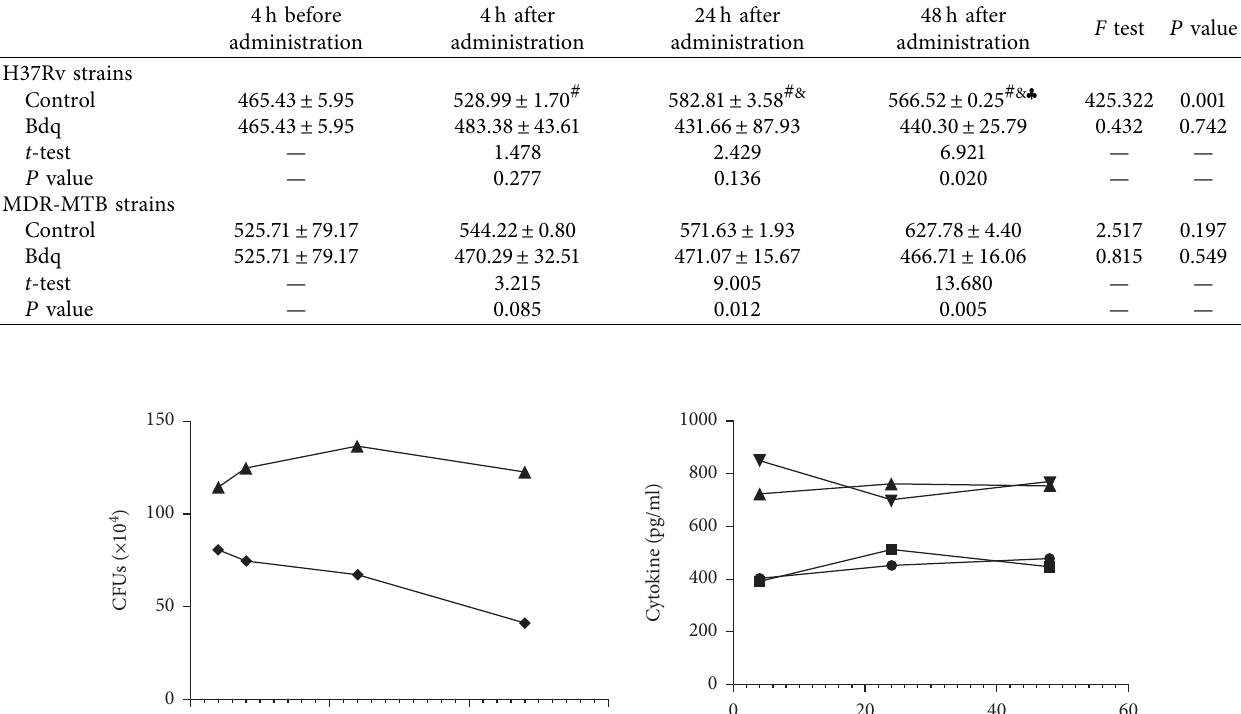
Table 6: Levels of IL-10 in culture supernatants of macrophages infected with H37Rv and MDR-MTB strains after Bdq administration (pg/ ml, x ± s ).